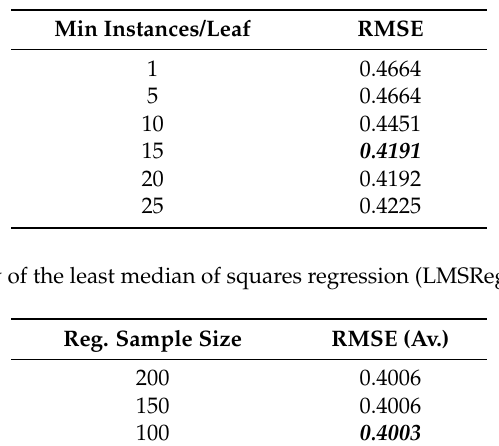
Table A4. Sensitivity of M5 model rules (M5Rules) to the minimum number of instances per leaf.